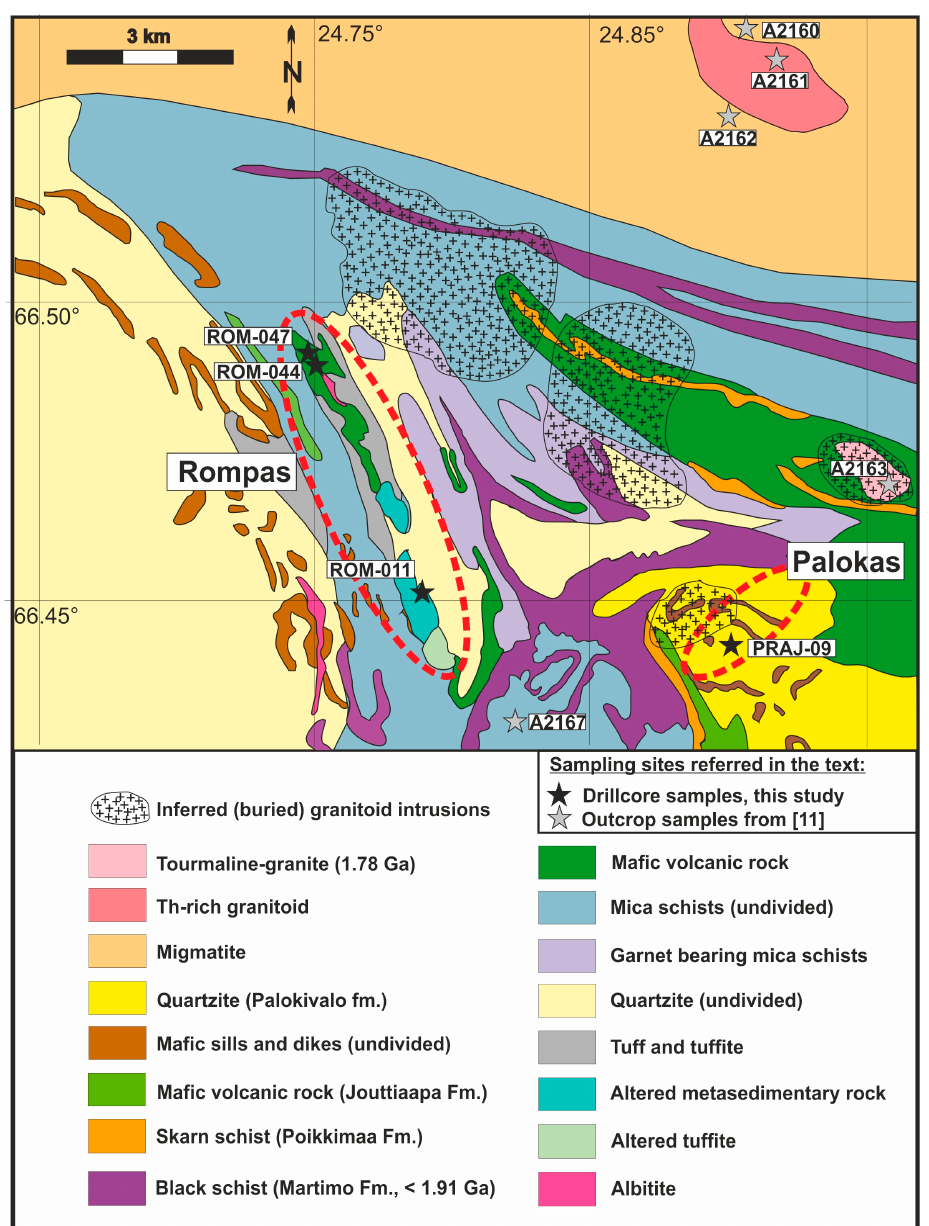
Figure 2. Local geology at the Rompas and Palokas properties and location of samples used in this study and previous geochronological studies. Modified after [6] using new interpretations by Mawson Resources.